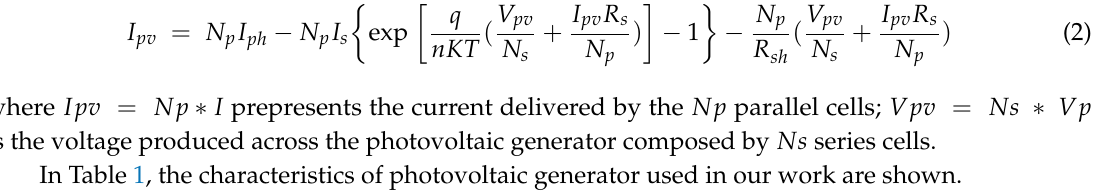
Table 1. Photovoltaic module parameters.